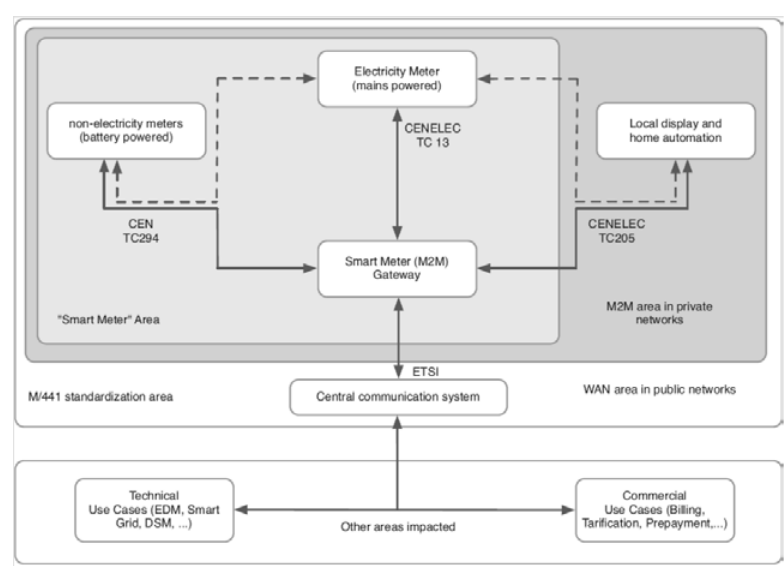
Figure 2 . Summary of the proposed responsibilities for the standardization work